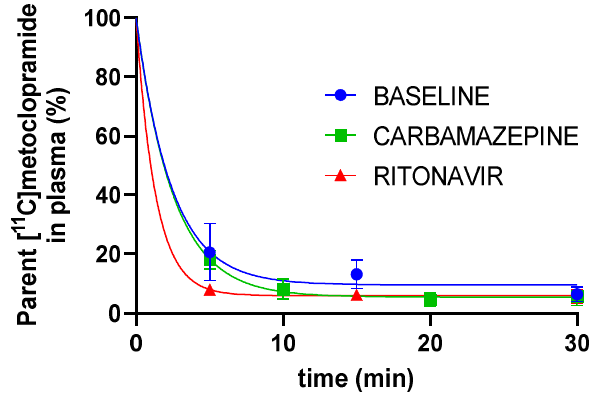
Figure 3. Fraction of parent (unmetabolized) [ 11 C]metoclopramide in plasma over time without and with pretreatment with carbamazepine or ritonavir (mean ± S.D with n = 3 per condition).